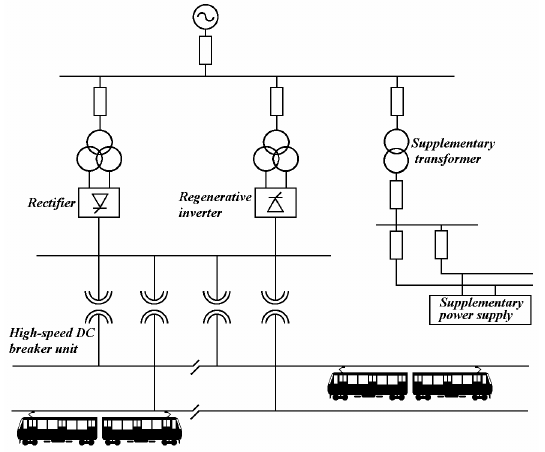
Fig 2. A scheme of linking electric power system and electrified railway